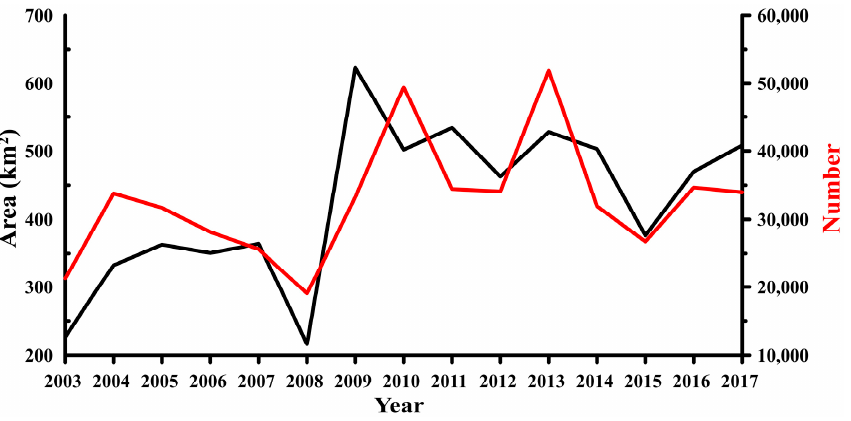
Figure 5. Temporal distribution of landslide area ( black line ) and number ( red line ) in 2003–2017 in Taiwan.